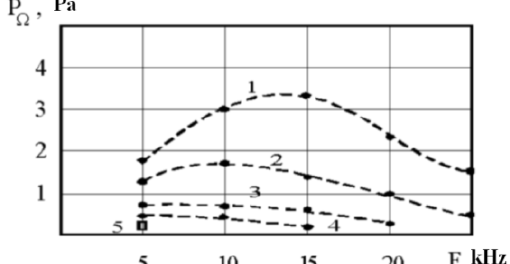
Fig. 1. Amplitudes of harmonic components of the difference frequency signal in the interaction of a six-component pump